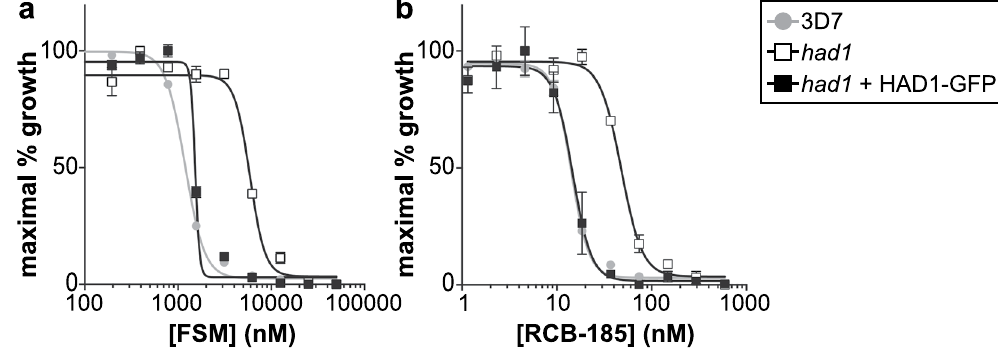
Figure 4. P. falciparum strains with high levels of the Dxr substrate DOXP confer RCB-185 resistance. Dose-dependent growth inhibition by FSM ( a ) or RCB-185 ( b ) was determined for the parental strain (3D7; closed circles, grey line), the FSM-resistant PfHad1 loss-of-function parasite strain ( had1 ; open squares, black line), and the FSM-sensitive complemented strain ( had1 + HAD1-GFP; closed squares, black line) as previously described 35 . For FSM, the parent strain has an IC 50 = 1021.5 ± 77.8 nM, while had1 has an IC 50 = 5348.1 ± 830.6 nM. For RCB-185, the parent strain has an IC 50 = 18.3 ± 1.9 nM, while had1 has an IC 50 = 76.5 ± 18.5 nM. Data (mean ± SEM) are representative of at least 3 independent biological replicates performed in